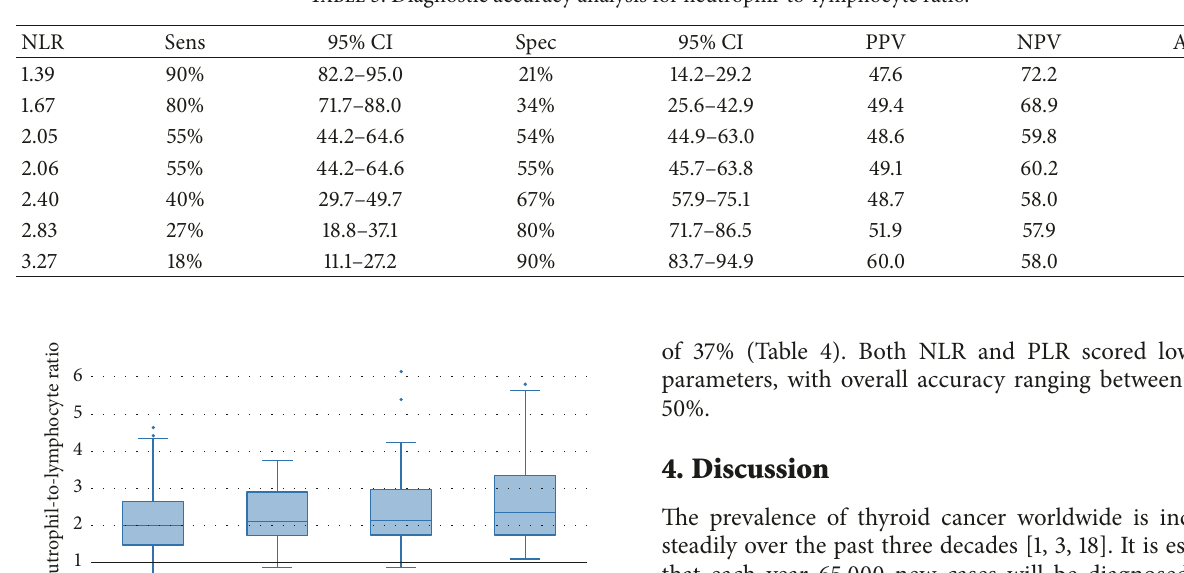
Table 3: Diagnostic accuracy analysis for neutrophil-to-lymphocyte ratio.